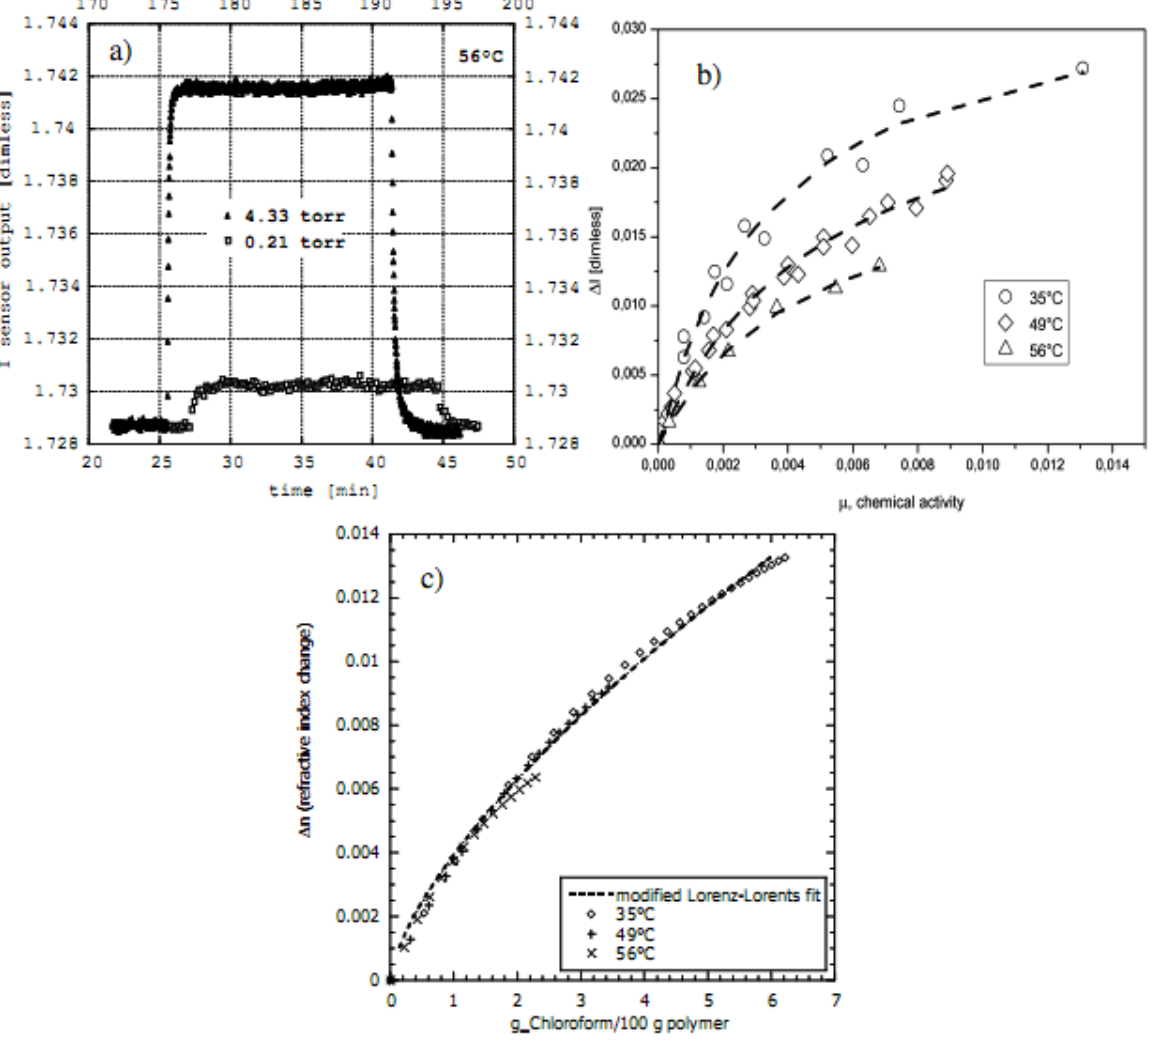
Figure 17. (a) Typical step responses of the s-PS coated fiber optic tip in the reflectometric configuration for different pressures of chloroform in vapor phase at 56 °C; (b) reflectometric sorption curves at different temperatures; (c) relationship between refractive index change of sPS and absorbed mass of